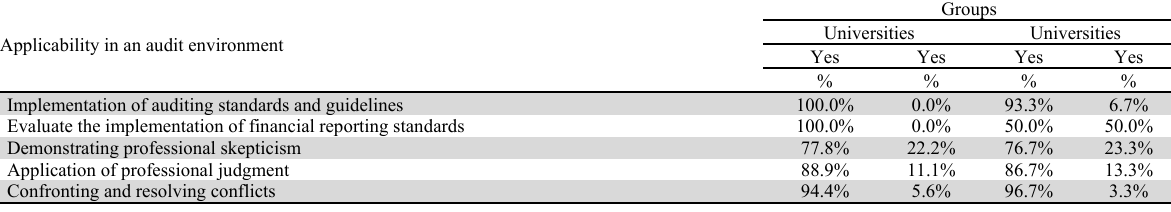
Values, ethics and attitudes